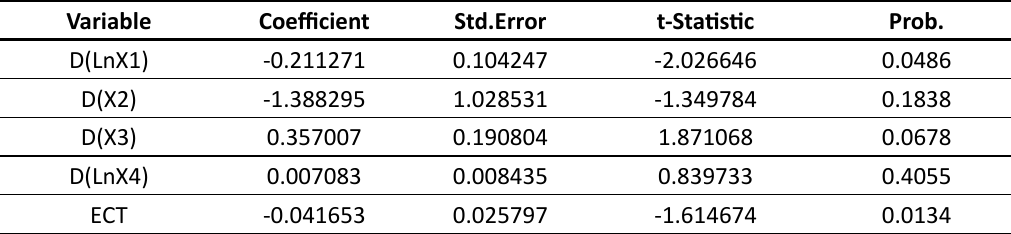
Table 4: Short Term Estimation